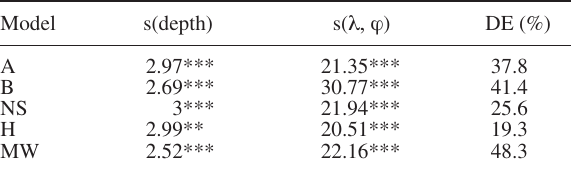
Fig . 2. – MDS ordination indicating the groupings with 60% similarity in different depth ranges, acquired through cluster analysis of elasmo- branch samples obtained during MEDITS and MIGJORN trawl surveys. Table 2. – The top 5 ranking species for each depth interval by Table 3. – Results of the generalized additive model for the com- abundance identified by SIMPER analysis (the abundance is ex- munity descriptors analysed ( A , abundance; B , biomass; NS , number pressed as a percentage of the total catch (%) for each bathymetric of species; H , diversity; MW , mean weight). Note that the selec- range and frequency of occurrence (f) as the number of samples in tion criteria are not shown because the most complete model in- which the species was caught in relation to the number of samples cluding both bathymetric, s(depth), and geographic, s( l, j ), terms taken at each depth stratum). was always the most parsimonious. For each model the intercept is year-specific and is shown in Figure 3. Asterisks denote signifi- cance levels: ***, p<0.001; **, p<0.01; *, p<0.05. DE refers to the percentage of variance